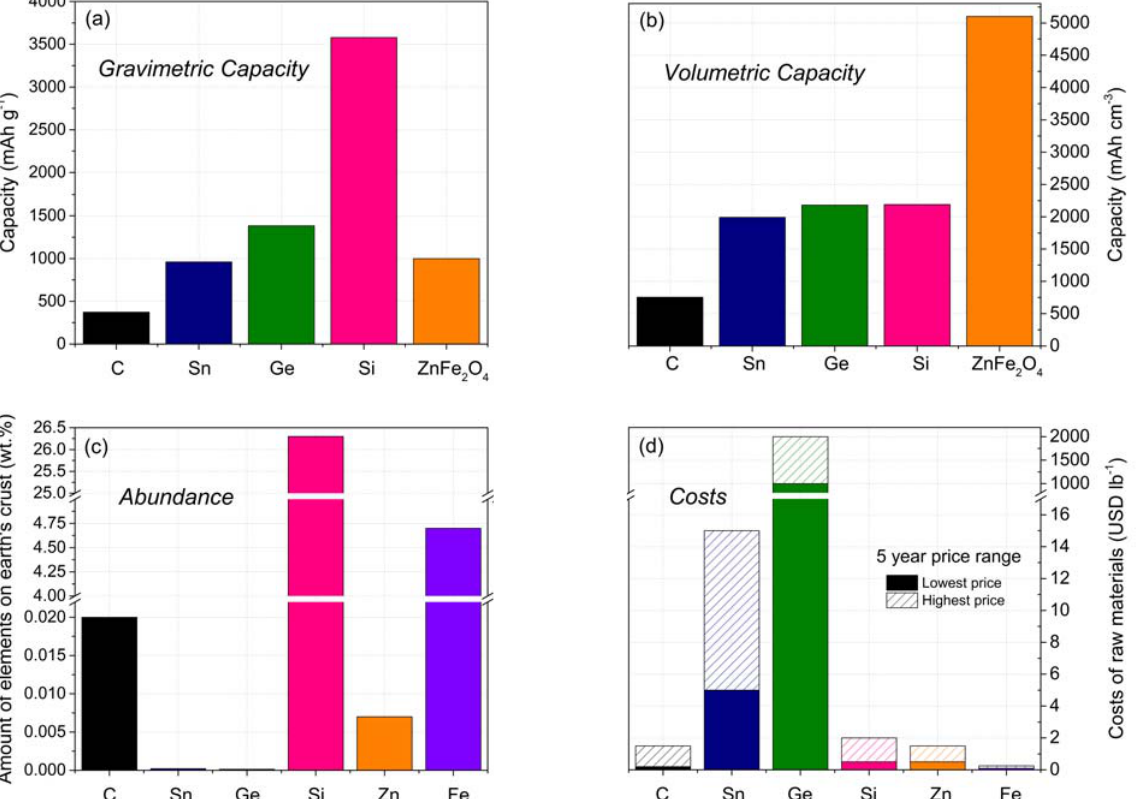
Figure 1. Gravimetric and volumetric lithium storage capacities of different anode materials, abundance of elements (as fraction of earth’s crust in wt.%) and costs of elements (approximate 5-year ranges, exept for Ge which is a 3-year range, according to 5